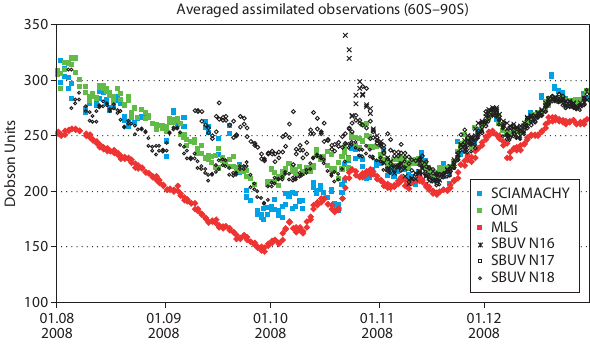
Fig. 2. Daily mean of assimilated ozone total columns inDU from SCIAMACHY and OMI and sum of partial columns from MLS and SBUV-2 aboard NOAA 16, 17 and 18 in averaged over Antarctica (60 ◦ S–90 ◦ S) in the period from 1 of August to 31 of December 2008.